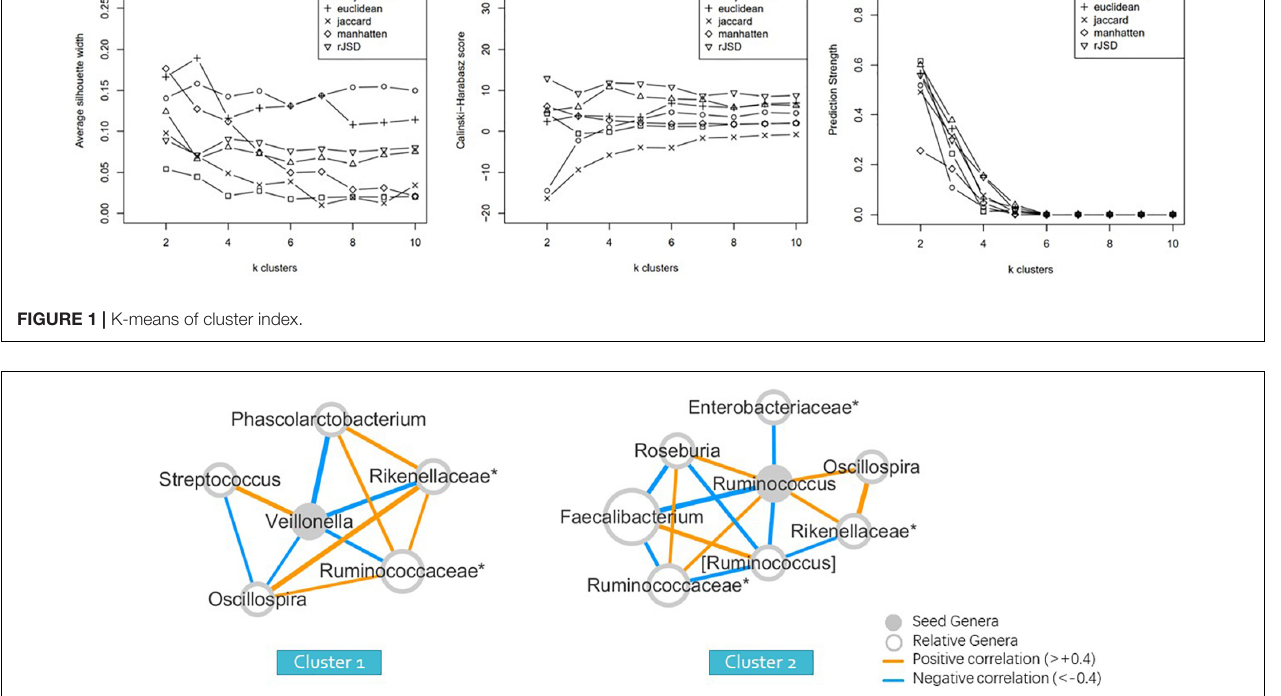
FIGURE 2 | Seed-genera and co-occurrence networks between clusters (wunifrac distance). “*” means the unclassified genera, and specified in the family to which the genera